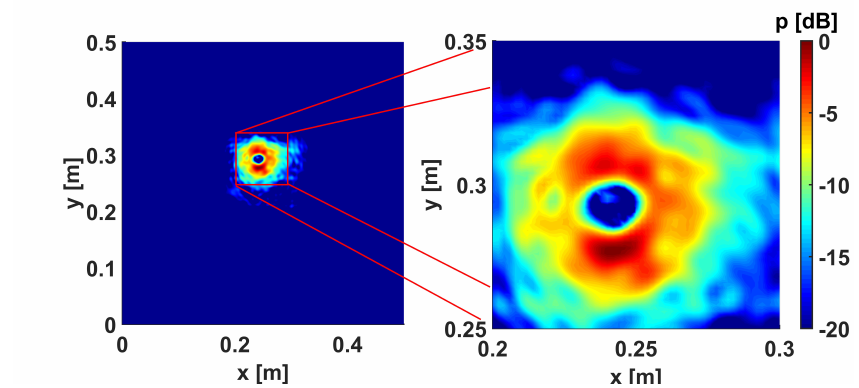
Figure 12. Amplitude at the top of the wooden particleboard with a ø20 mm piece of paper. Evaluated with the spec-radiation method for the frequency 50 kHz, with d x = d y = 2 mm and a grid of the size 256 × 256